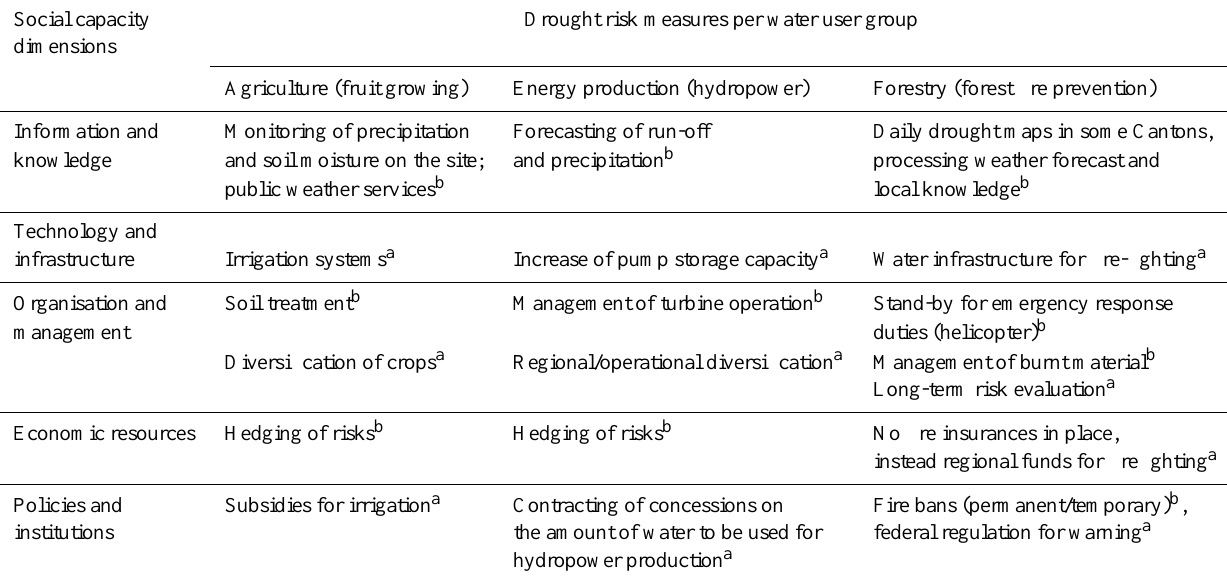
Table 3. Overview on proactive and reactive drought risk measures in three selected water user groups in Switzerland ( a proactive measures; b reactive mitigation measures).